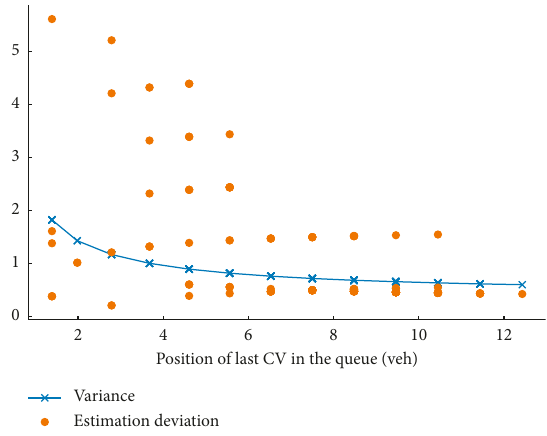
Figure 9: NMAE analysis for different cycle and red times.